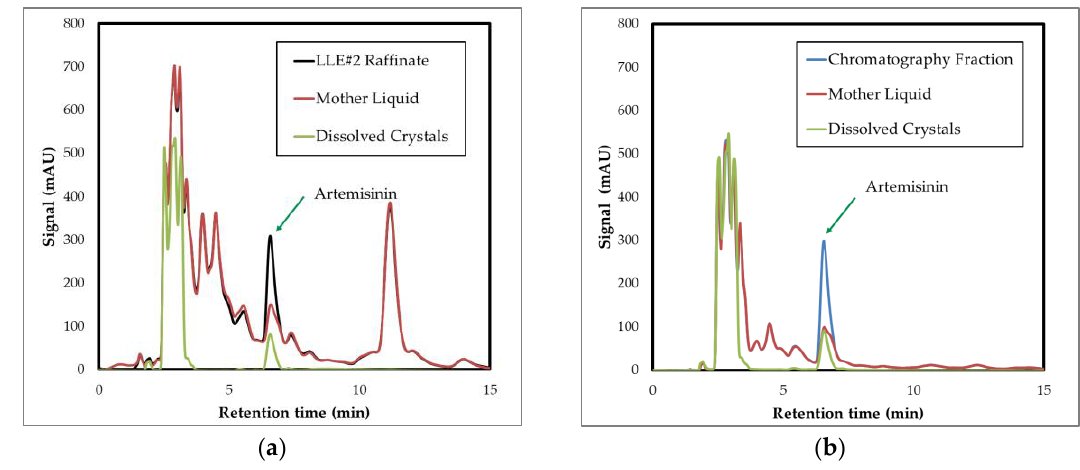
Figure 12. HPLC analysis of crystallization experiments of ( a ) LLE#2-raffinate and ( b ) chromatography fraction. (HPLC: High performance liquid chromatography).